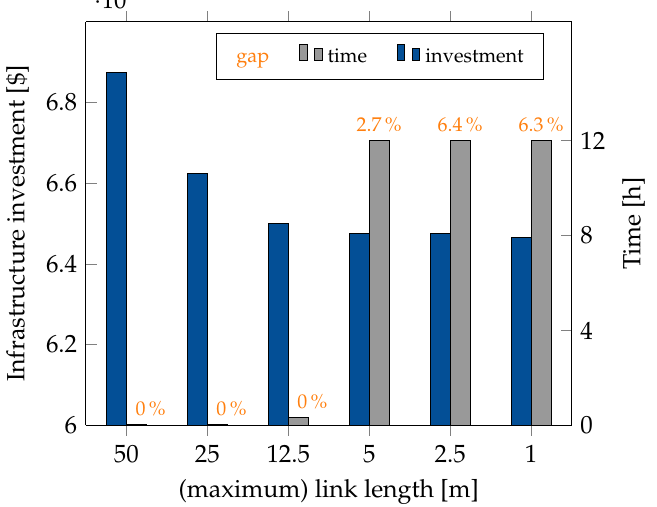
Figure 6. Impact of shorter links in the Fictitious Airport instance (Time limit: